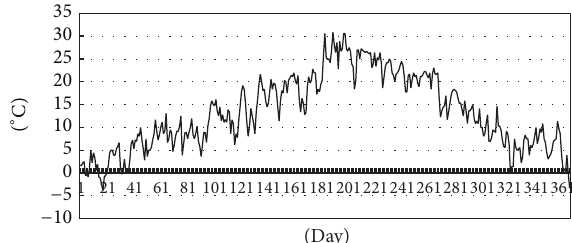
Figure 12: Daily average temperature in 2014 in